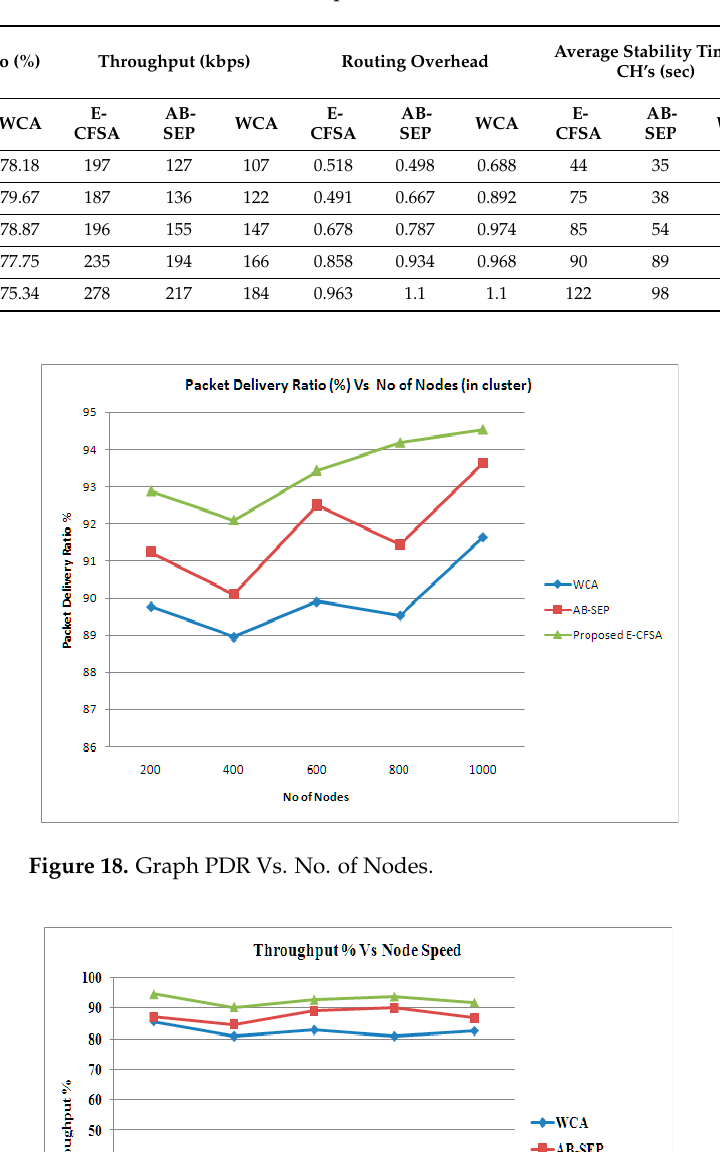
Figure 20. Graph Avg Lifetime Vs. No. of Nodes.